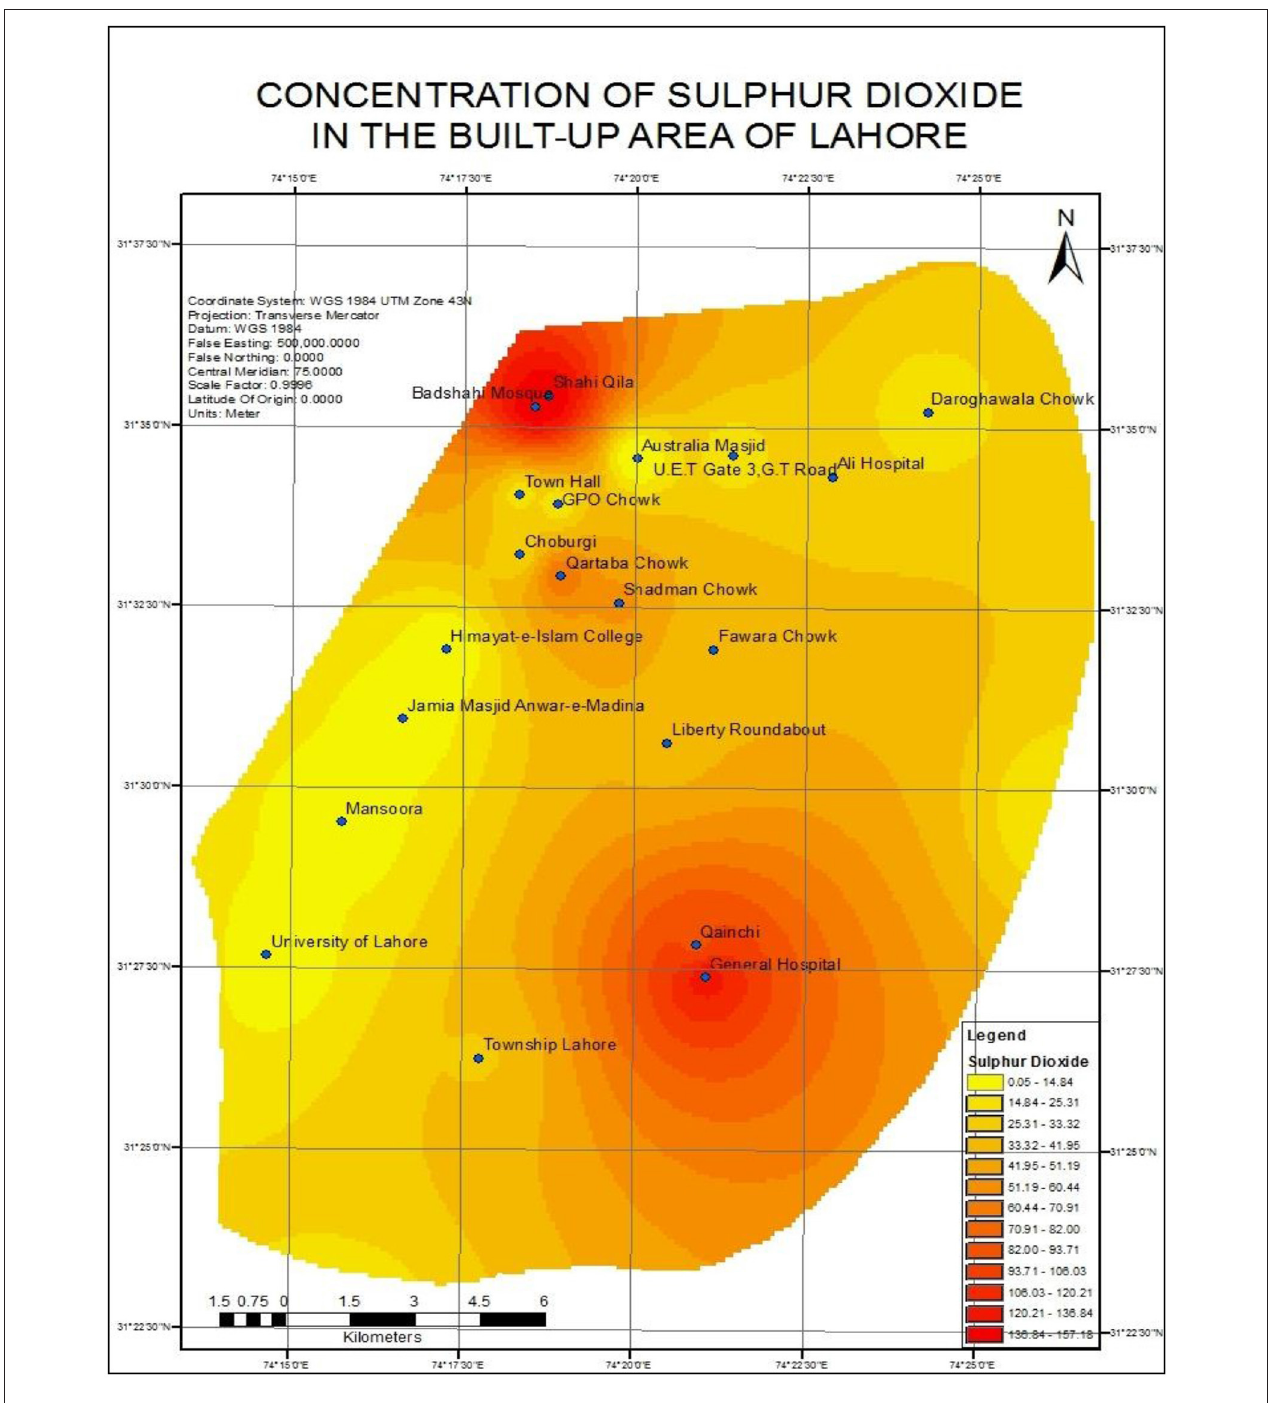
FIGURE 8 | Concentration of sulfur dioxide.